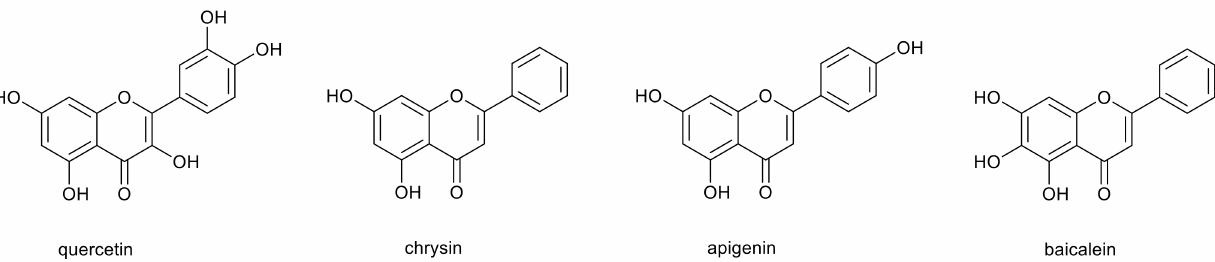
Figure 1. Chemical structures of selected polyphenols.